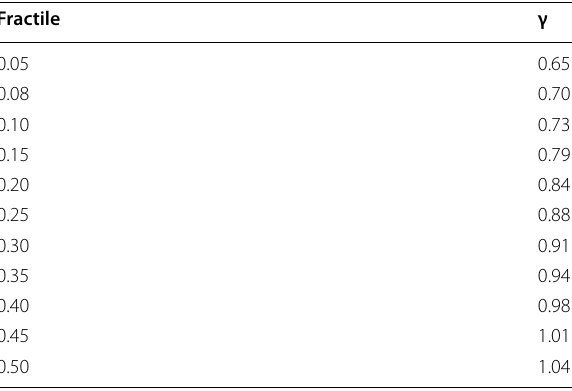
Table 8 Relationship between safety factor and fractile